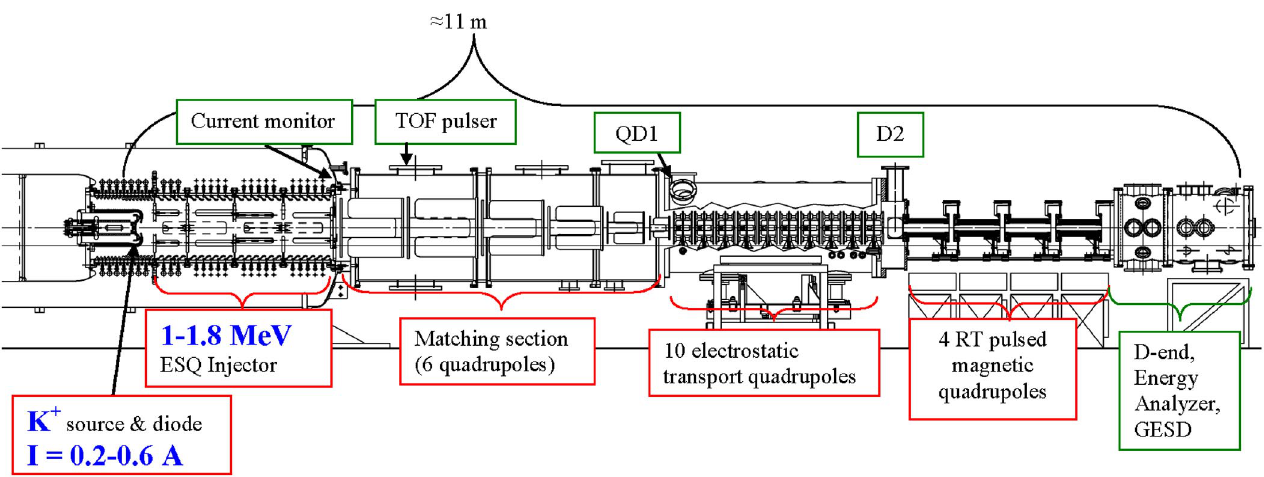
The Marx voltage drifts due to changes in the conduc- tivity of the water resistor. We keep the peak beam energy